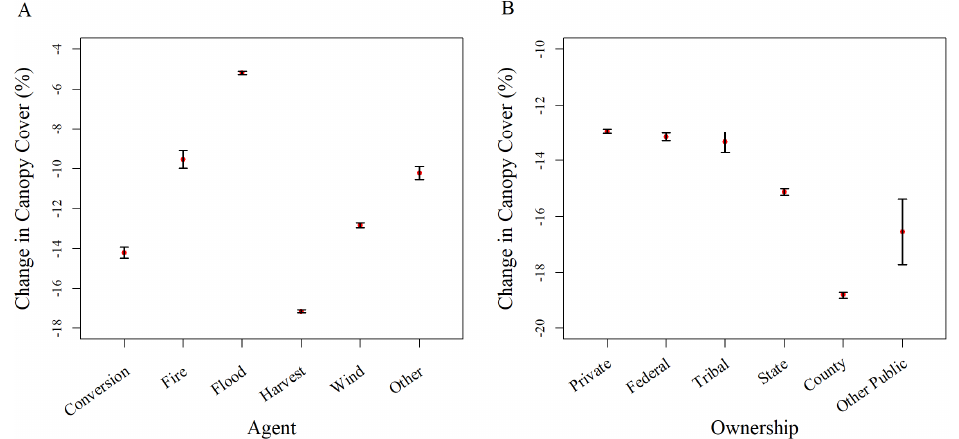
Figure 4. Mean patch-level change in canopy cover by ( A ) agent and ( B ) ownership for disturbances represented by the Minnesota most recent fast disturbance maps for the period 1974–2018. The error bars represent the 95% confidence interval around the mean. Note: change in canopy cover is calculated as the mean pre-disturbance canopy cover subtracted from the mean post-disturbance canopy cover.